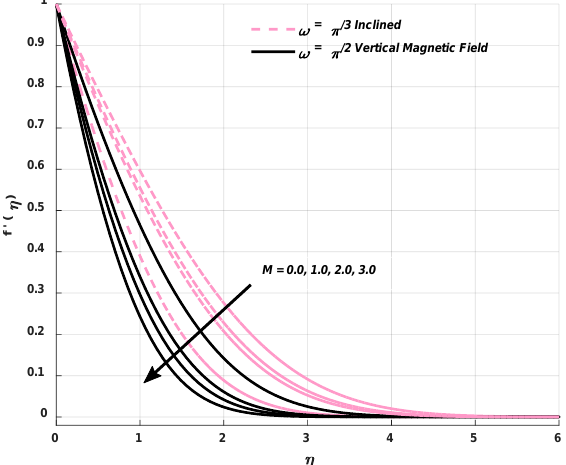
Figure 6. Disclose the effect of n versus f (cid:48) ( η ) .